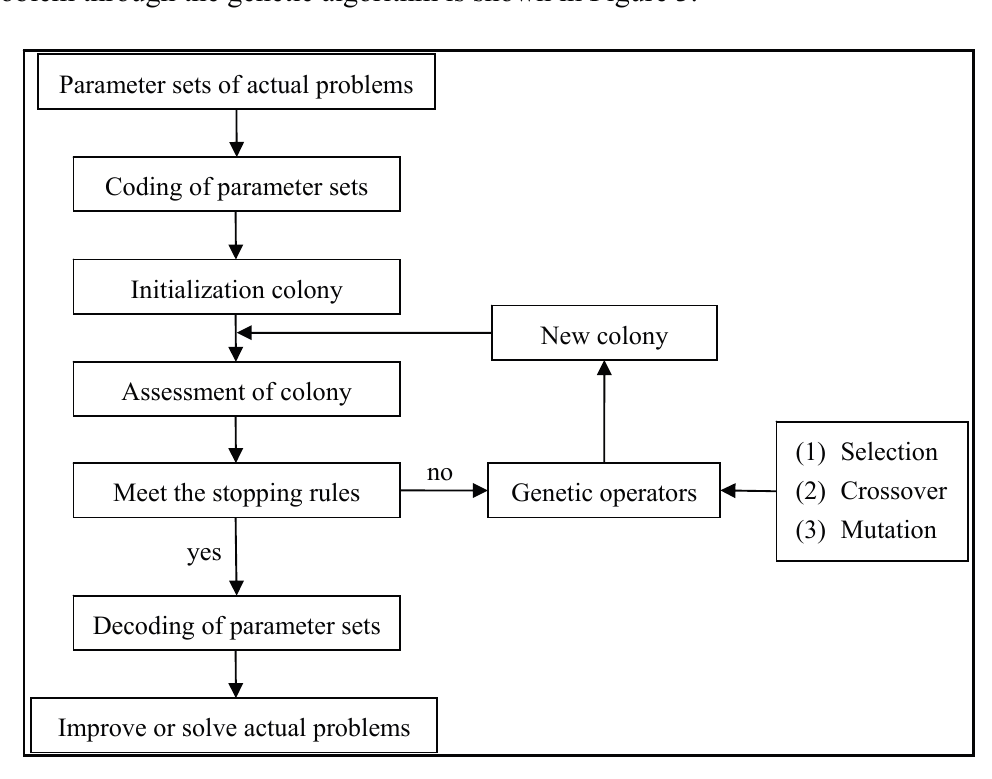
Figure 3. Process of the genetic